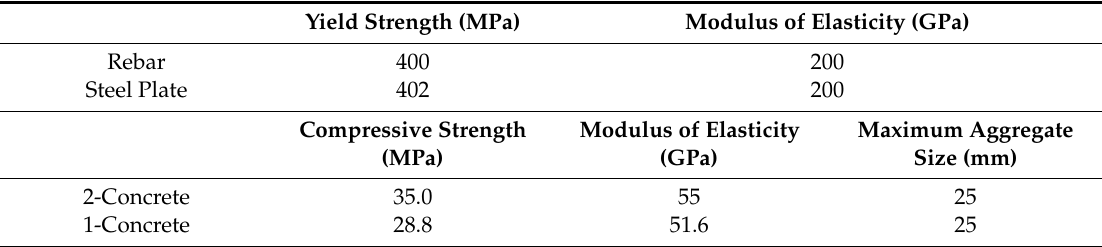
Table 1. Material